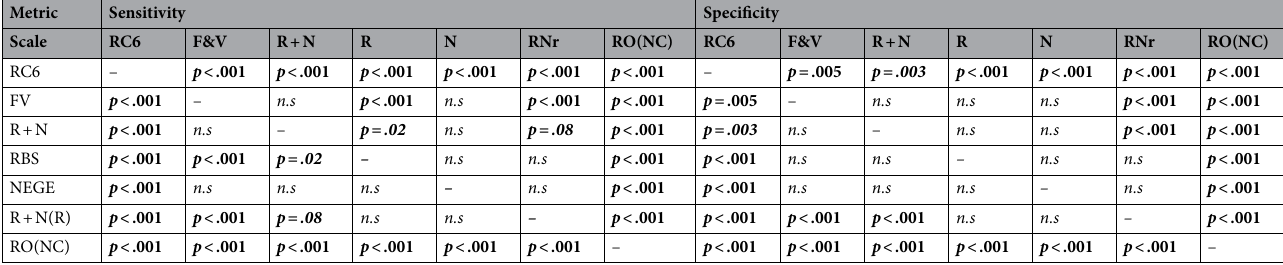
Table 3. Tukey post-hoc test results for sensitivity and specificity metrics across prediction source. [RC6 (PC): Restructured Clinical 6 (Positive Control); F&V: Fenigstein & Vanable; R + N: RBS + NEGE (Combined); R: